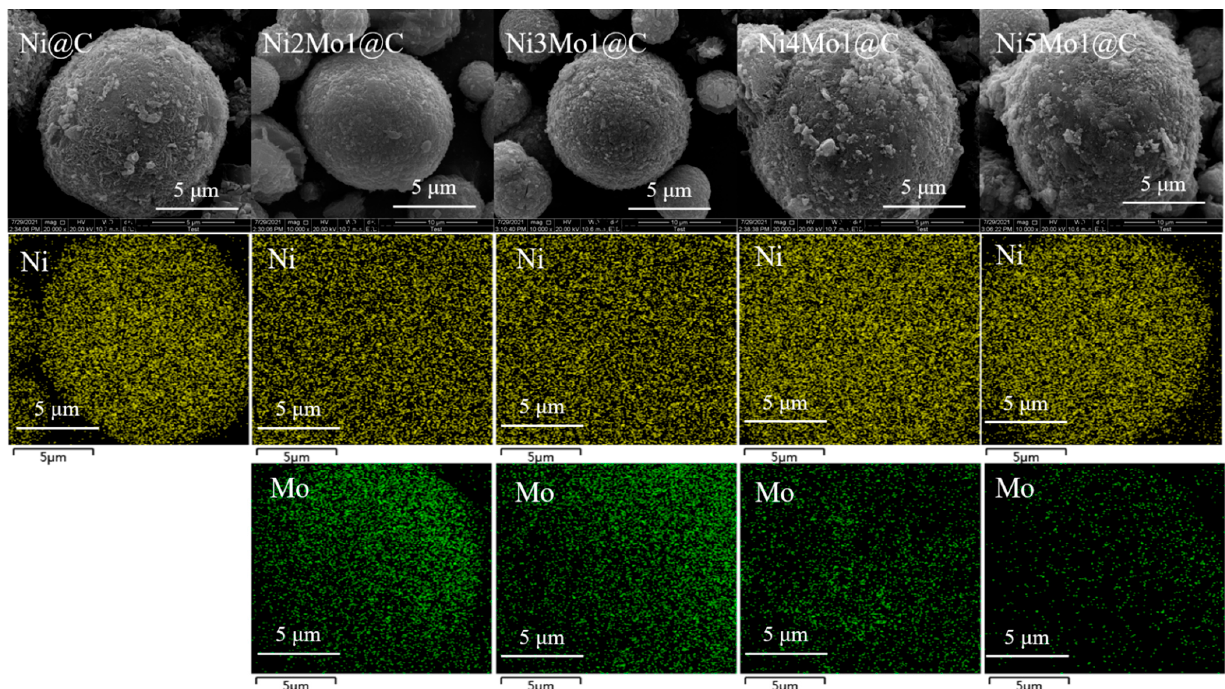
Figure 2. SEM images and elemental mappings of Ni@C, Ni2Mo1@C, Ni3Mo1@C, Ni4Mo1@C, and Ni5Mo1@C.